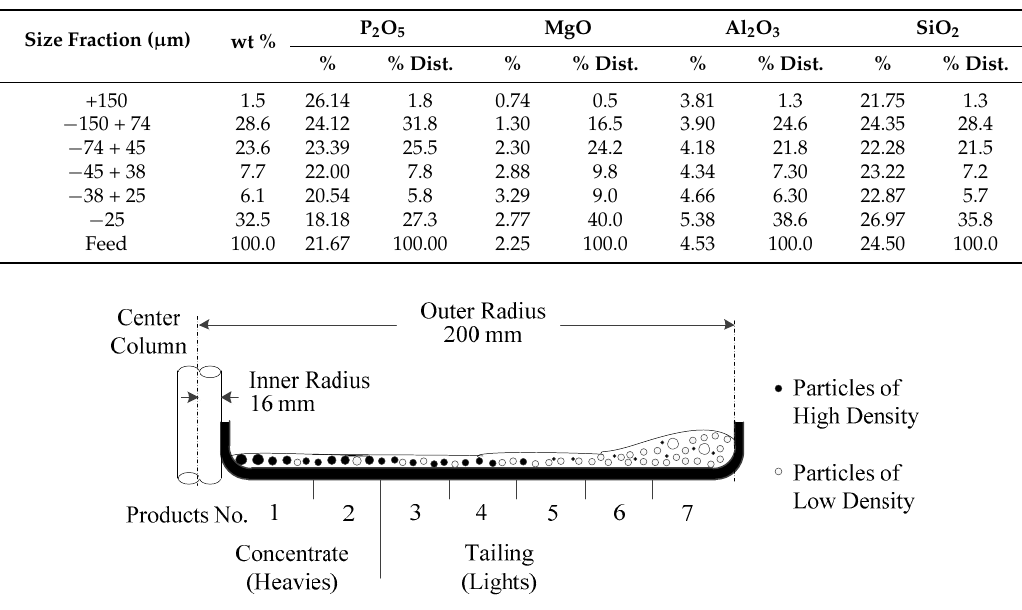
Figure 6. A sectional view of the spiral trough flow.